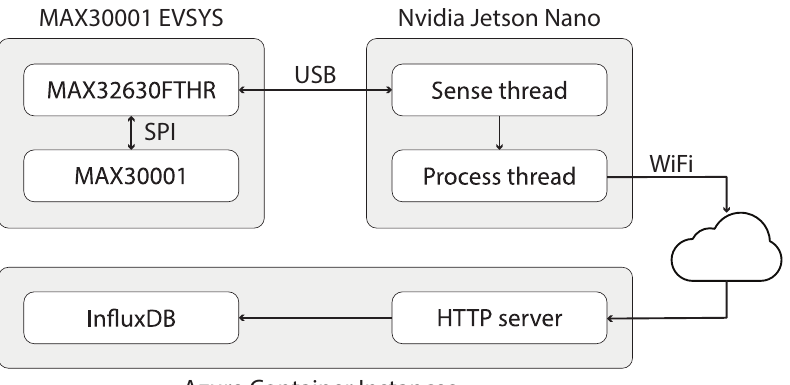
Figure 1. The sensor-edge-cloud architecture is composed of a MAX30001 EVSYS as ECG sensor, an Nvidia Jetson Nano as the edge device, and an HTTP server with InfluxDB database deployed to Azure Cloud